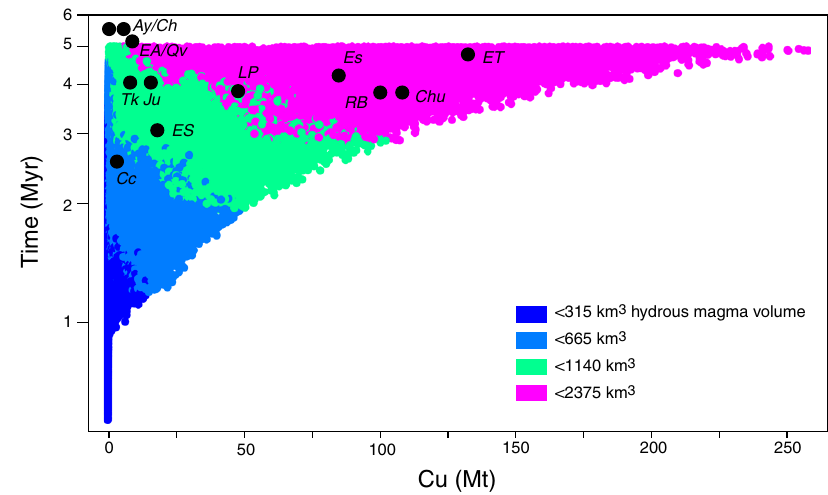
Fig. 2 Cu endowments (Mt) versus duration of magma injection into the crust. Plot showing Cu endowments (Mt) versus duration of magma injection into the crust (Myr). Colored dots are 50% precipitation ef fi ciency simulations from 17 and different colors indicate the volumes of the magma accumulated as speci fi ed in the legend. The black dots are porphyry copper deposits for which data are available for Cu endowments and duration of magmatic activity 13,17 (Supplementary Data 1). Ay Antapaccay, Ch Chaucha, Chu Chuquicamata, Cc Coroccohuayco, Es Escondida, EA El Abra, ES El Salvador, ET El